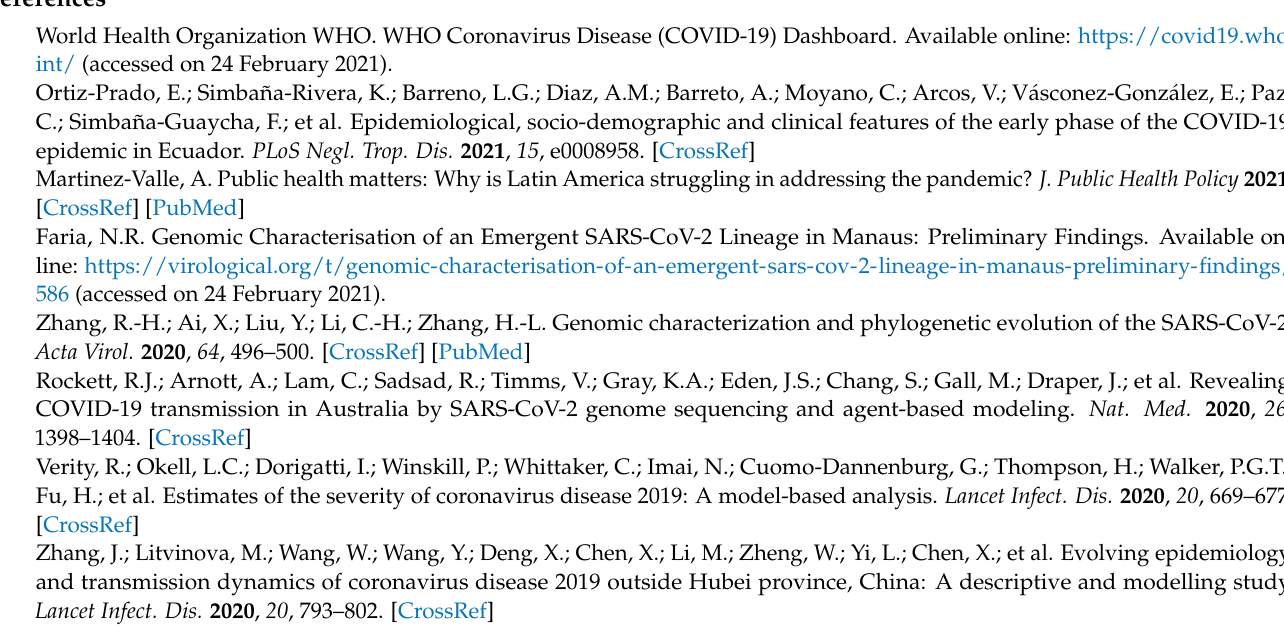
bia, Table S1: Characteristics of laboratory-confirmed COVID-19 cases, Supplementary Data S1: Incidence rates per 100,000 population by region, Supplementary Data S2: Results of the Rt.live model, Supplementary Data S3: WHO model